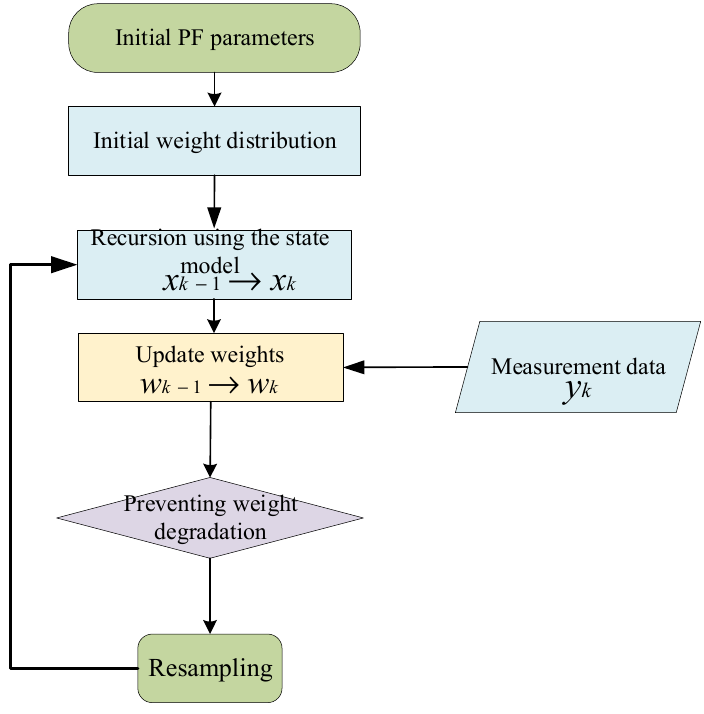
Figure 5. Flow chart of PF.